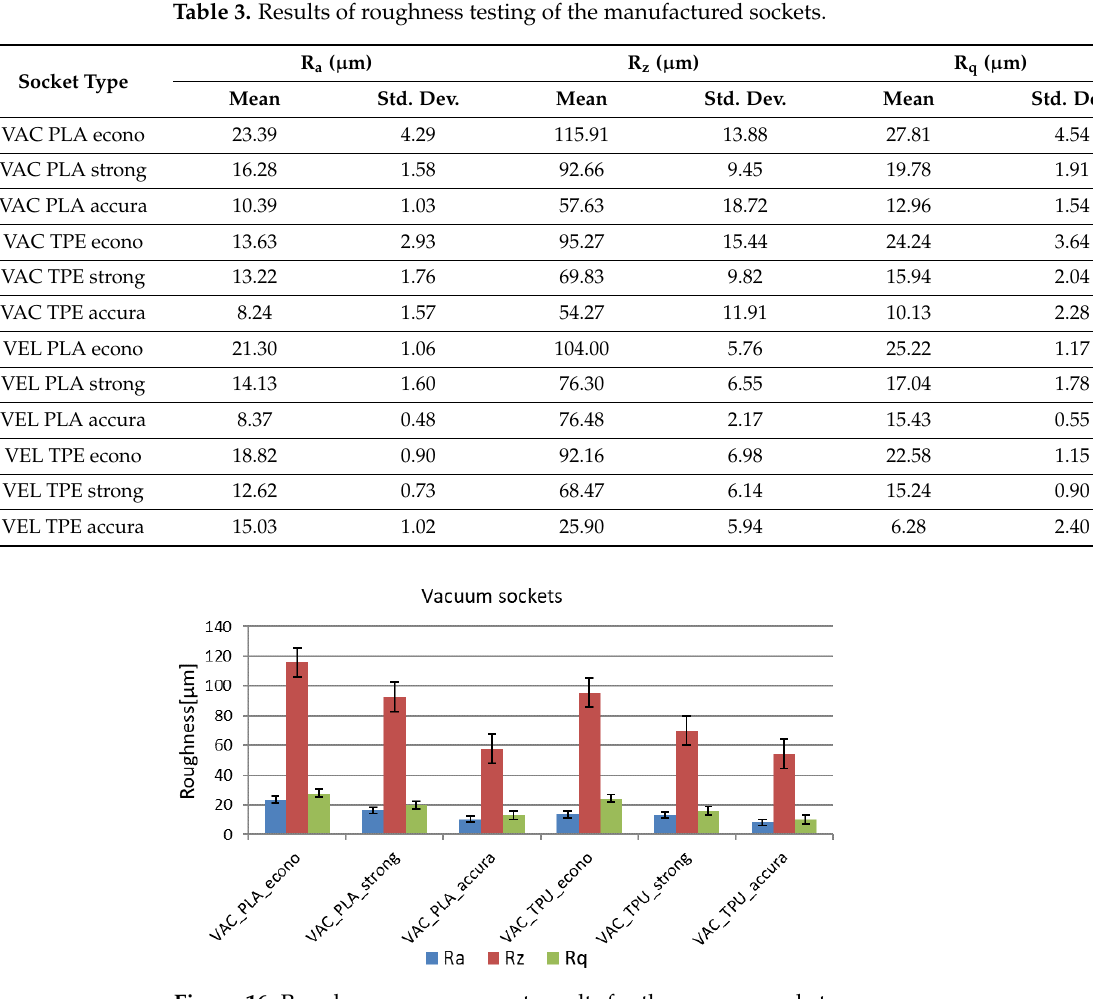
Table 3. Results of roughness testing of the manufactured sockets.